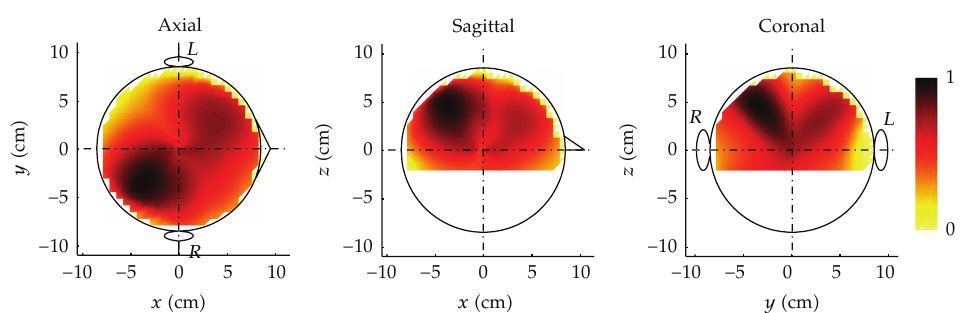
Figure 2: Correlation distribution for two dipole source problems on the entire source region of the brain. Darker color represents a higher correlation